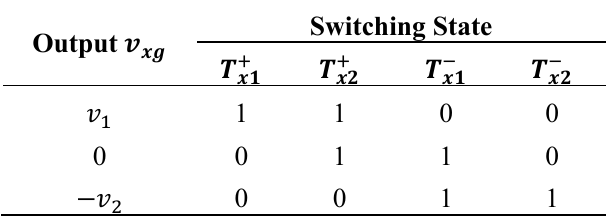
Figure 3. Schematic of a three-phase, three-level rectifier. Table 1. Phase voltages of the three-phase, three-level